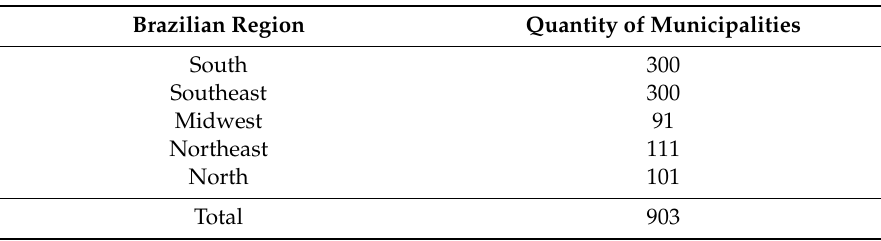
Table 6. Population and sample—large-scale